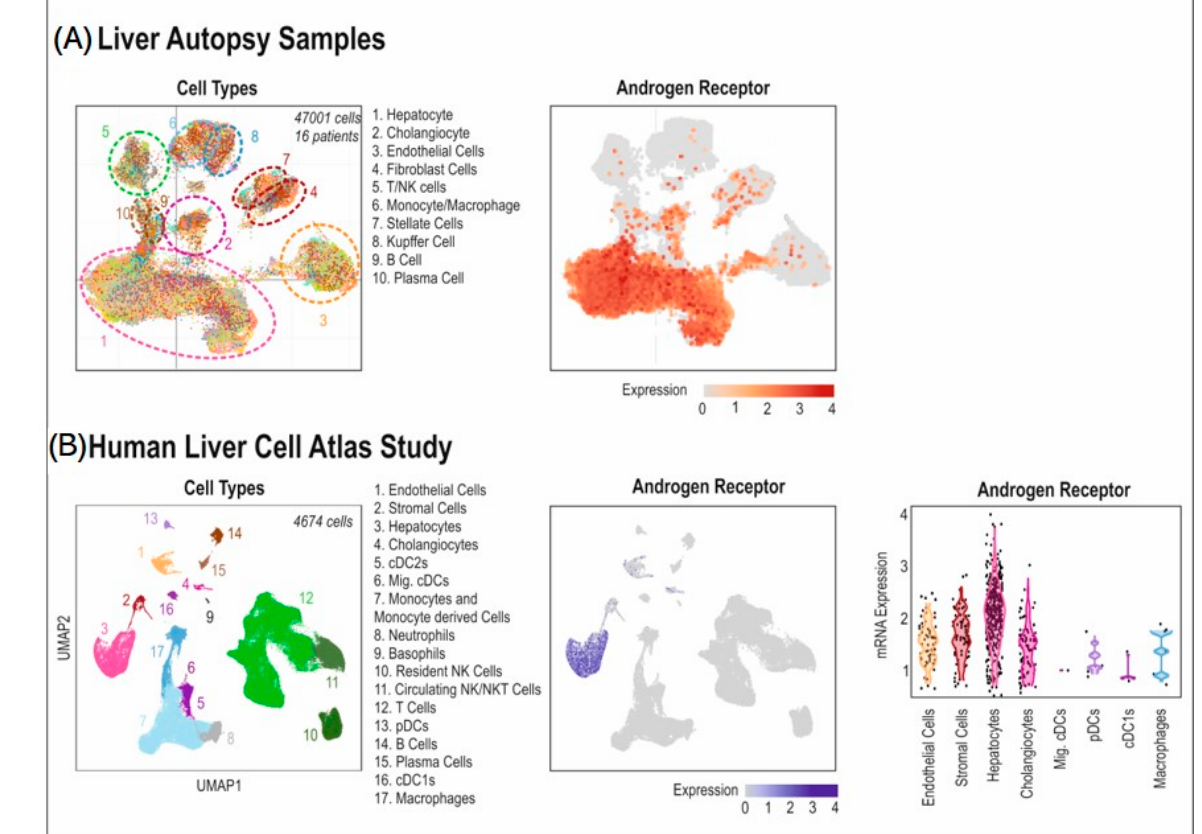
Figure 3. AR expression in the cells of the liver. Single cell RNA-seq analysis of human liver from two different studies. ( A ) Liver autopsy samples [118] of 47,001 cells in total from 16 patients. (i) UMAP graph of single cells collected from different patients’ livers. Each sample is colored by which patient they come from, and surrounded by a dotted line indicating which cell types compose each group. (ii) Analysis of AR expression in each single cell, with expression scaled from grey (no expression) to increasing shades of red (increasing levels of AR expression). ( B ) The Human Liver Cell Atlas Study (GSE192742 [119]), comprised of 4647 cells from human liver. (i) UMAP graph showing the cell-types present in this sample. (ii) Analysis of AR expression in each single cell, with expression scaled from grey (no expression) and deepening shades of blue (increasing levels of AR expression). (iii) Violin plots of AR expression in a sub-set of the cell-types detected in the